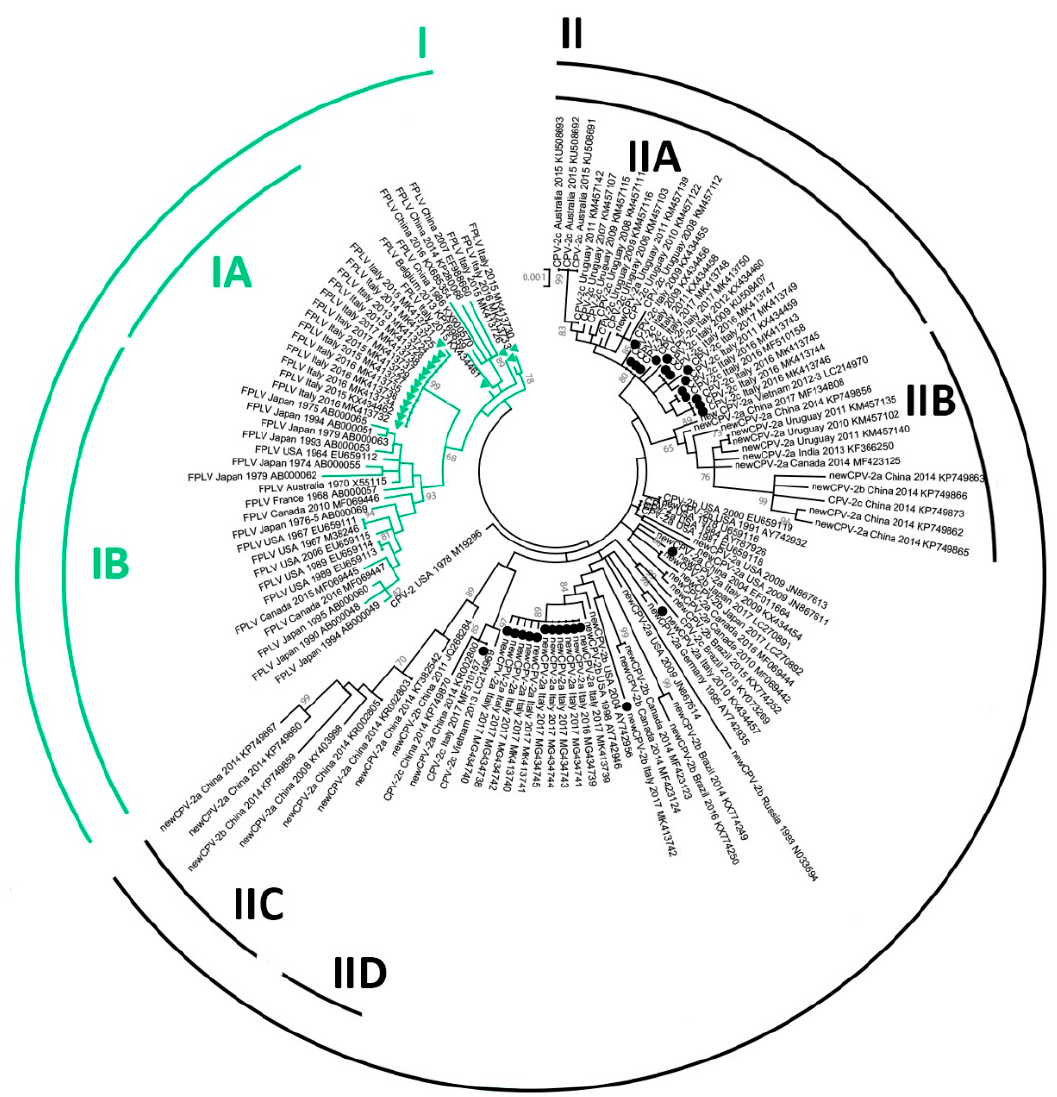
Figure 1. Maximum-likelihood tree based on 133 complete NS1 gene sequences of feline panleukopenia virus (FPLV, in green) and canine parvovirus type 2 (CPV-2, in black) strains (bootstrap 1000 replicates; bootstrap values greater than 65 are shown). Green triangles and black dots indicate, respectively, FPLV and CPV strains analyzed in this study. Each sequence is indicated with virus type (FPLV / CPV) or variant (CPV-2, CPV-2a, CPV-2b, CPV-2c), country and year of collection, and accession number. The term “new” was used to distinguish the CPV-2a / 2b strains with S297A main capsid protein (VP2) amino-acid changes from the early CPV-2a / 2b variants. The same tree with more information about used strains (strain / isolate name) is available in Figure S6 (Supplementary